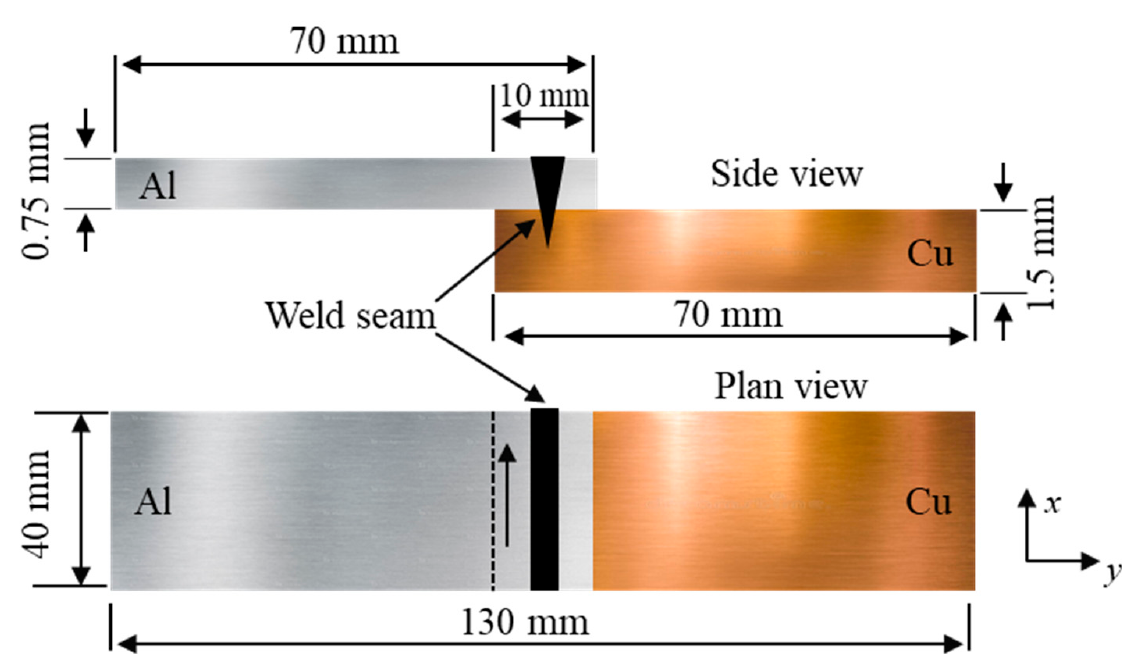
Table 2. Laser process conditions used in the experiment.